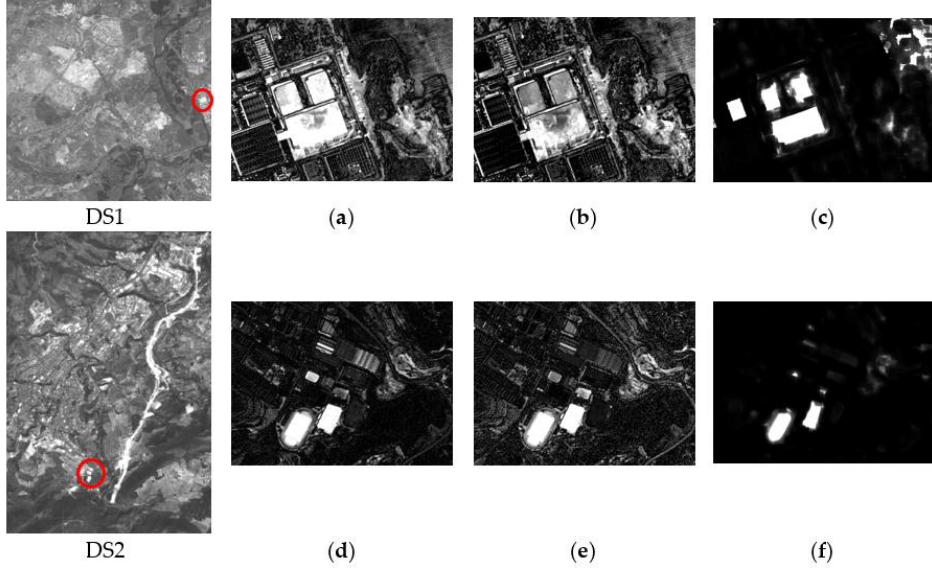
Figure 9. Enlargement for the highlighted areas in the corresponding CDIs in DS1 and DS2: